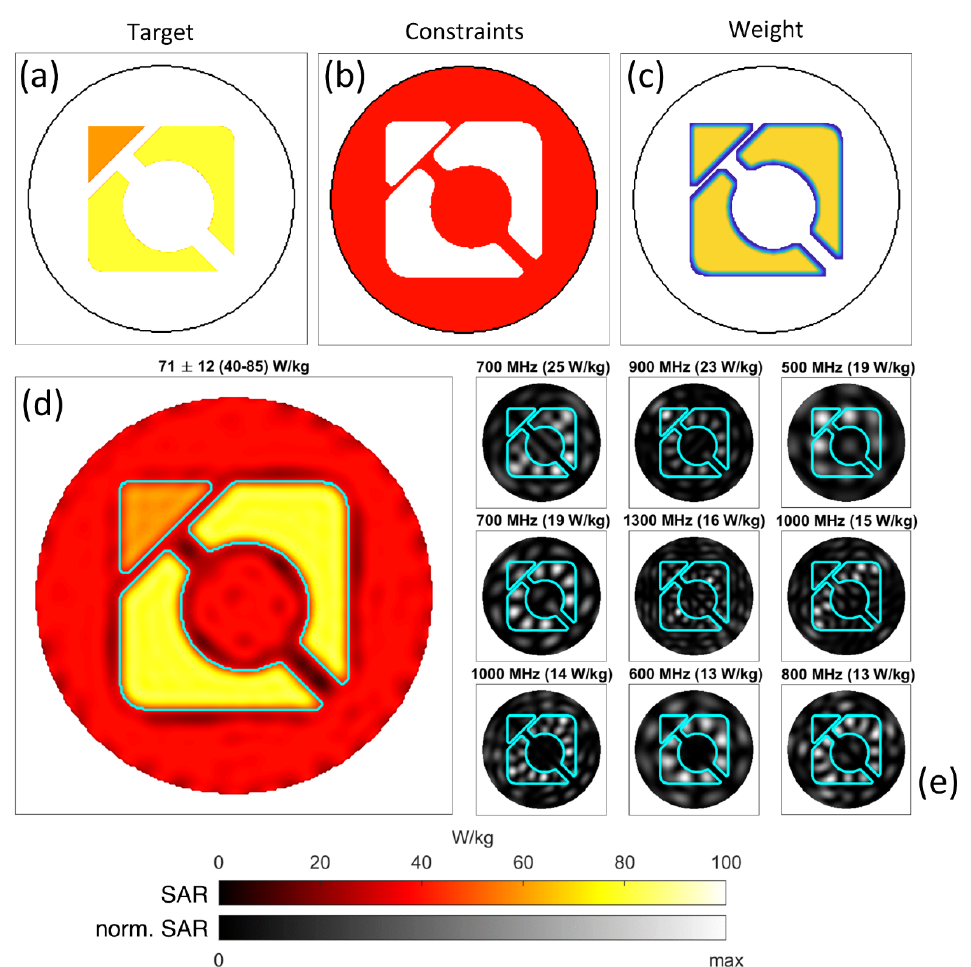
Figure 5. Excitation of a complex disjoint shape inside the water phantom (the logo of the first author’s affiliation). The top row shows the target pattern with 60 and 80 W/kg regions ( a ), constraints of 40 W/kg ( b ), and weighting distribution ( c ) used for the optimization. The achieved heating pattern is shown in ( d ), which requires time- and frequency-multiplexed excitation using 43 different modes between 500 and 2000 MHz. The first nine modes with the strongest peak impact are shown in ( e ). Measures of SAR within the target region are detailed in the header (Mean ± SD (Min–Max)).